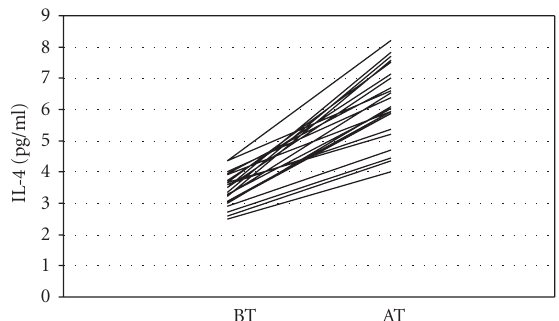
Figure 2: Interleukin-4 (IL-4) levels before (BT) and after (AT) ser- traline treatment.